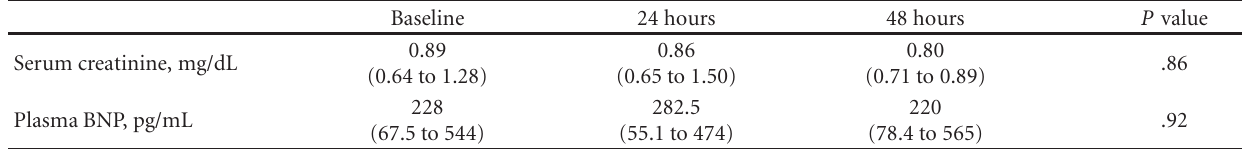
Table 2: Median of creatinine and BNP of all patients during 48 hours.